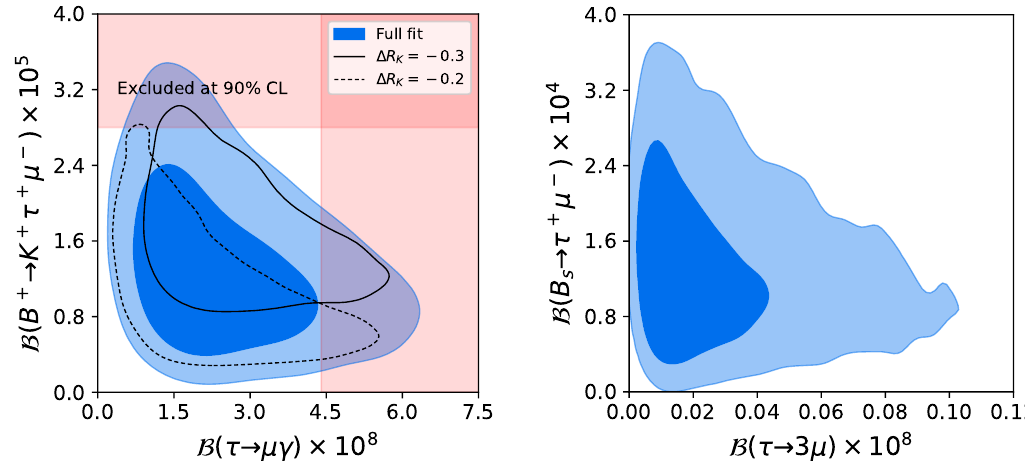
Figure 7 . Left: 68% (dark blue) and 95% (light blue) posterior probabilities of B ( (cid:28) ! (cid:22)(cid:13) ) and B ( B + ! K + (cid:28) + (cid:22) (cid:0) ) from the global (cid:12)t. The black lines denote the 95% posterior probabilities (cid:12)xing (cid:1) R K = (cid:0) 0 : 3 (solid) and (cid:1) R K = (cid:0) 0 : 2 (dashed). The red bands show the 90% CL exclusion limits for these observables. Right: 68% (dark blue) and 95% (light blue) posterior probabilities of B ( (cid:28) ! 3 (cid:22) ) and B ( B s ! (cid:28) + (cid:22) (cid:0) ) from the global (cid:12)t. in (cid:12)gure 7 (right). However, in this case the e(cid:11)ect is diluted by the uncertainty on Z 0 mass and couplings, which are not strongly constrained by other